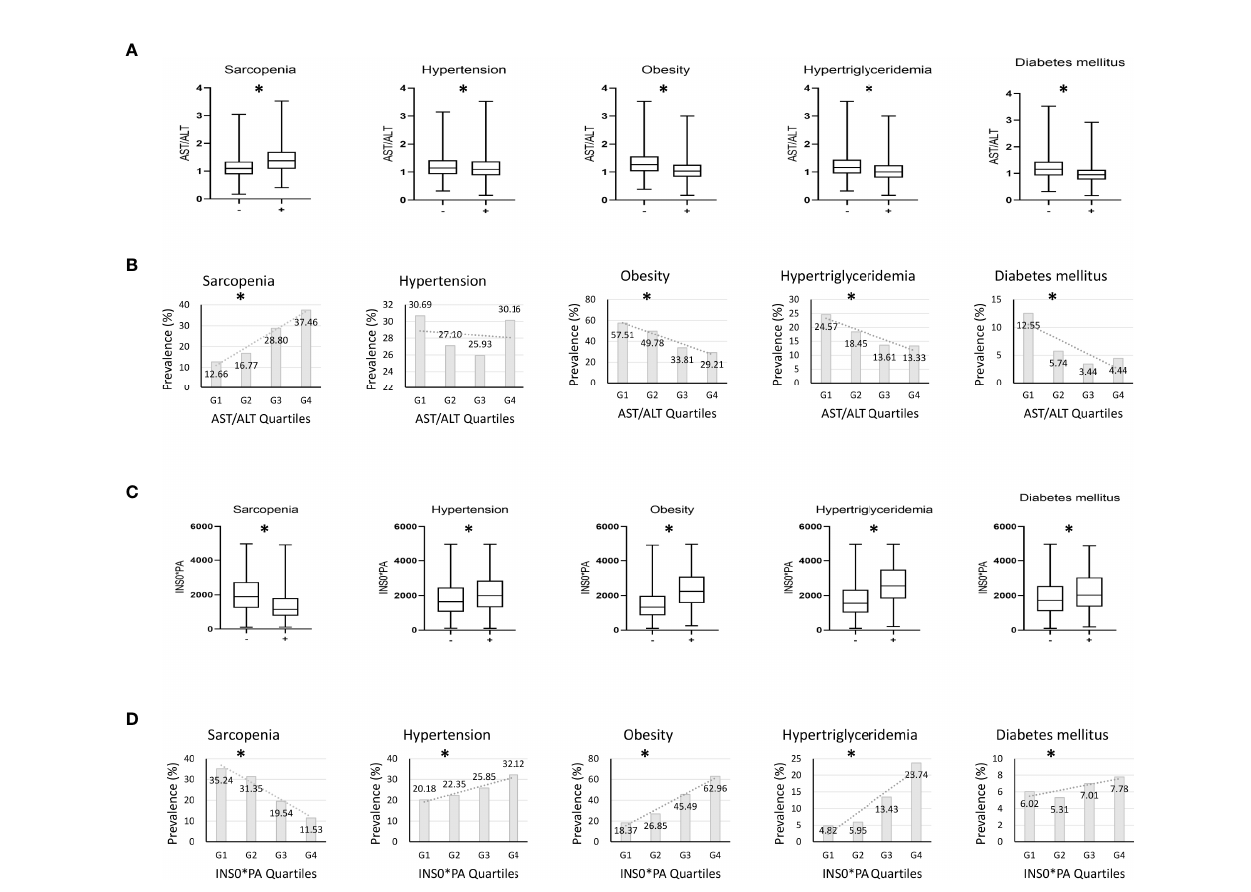
FIGURE 1 | Investigation on whether AST/ALT and INS*PA are affected by metabolic factors. (A) Differences in serum aspartate aminotransferase/alanine aminotransferase (AST/ALT) according to the presence of accompanying sarcopenia or metabolic disorders. (B) The prevalence of sarcopenia and metabolic disorders according to AST/ALT quartiles. (C) Differences in serum fasting insulin*prealbumin (INS*PA) according to the presence of accompanying sarcopenia or metabolic disorders. (D) The prevalence of sarcopenia and metabolic disorders according to INS*PA quartiles. (A, C) * P < 0.05 between groups; (B, D) * P for trend <